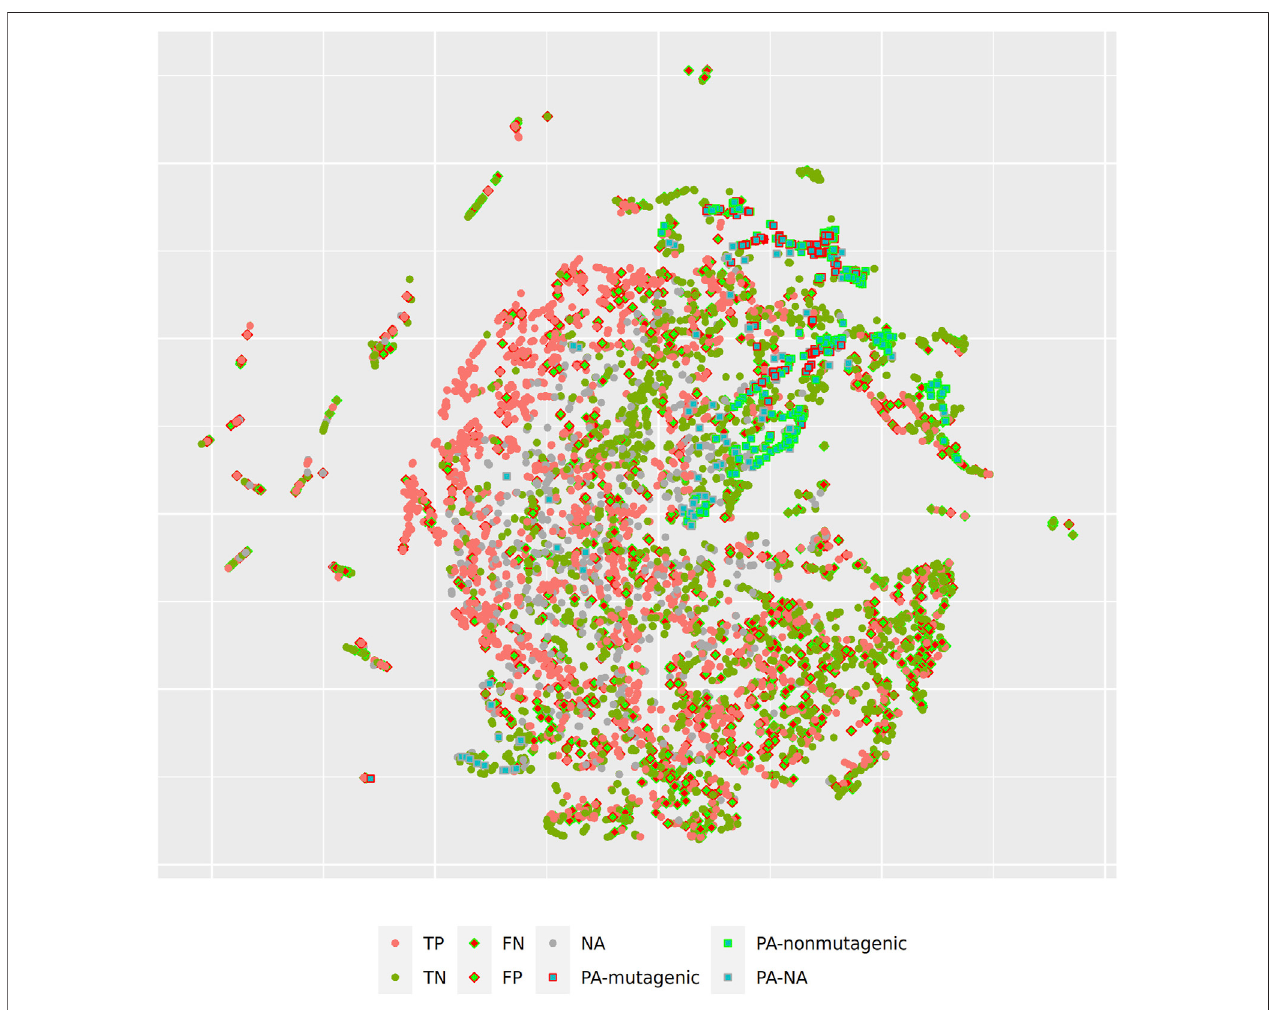
FIGURE 6 | t-SNE visualization of all CDK lazar predictions.